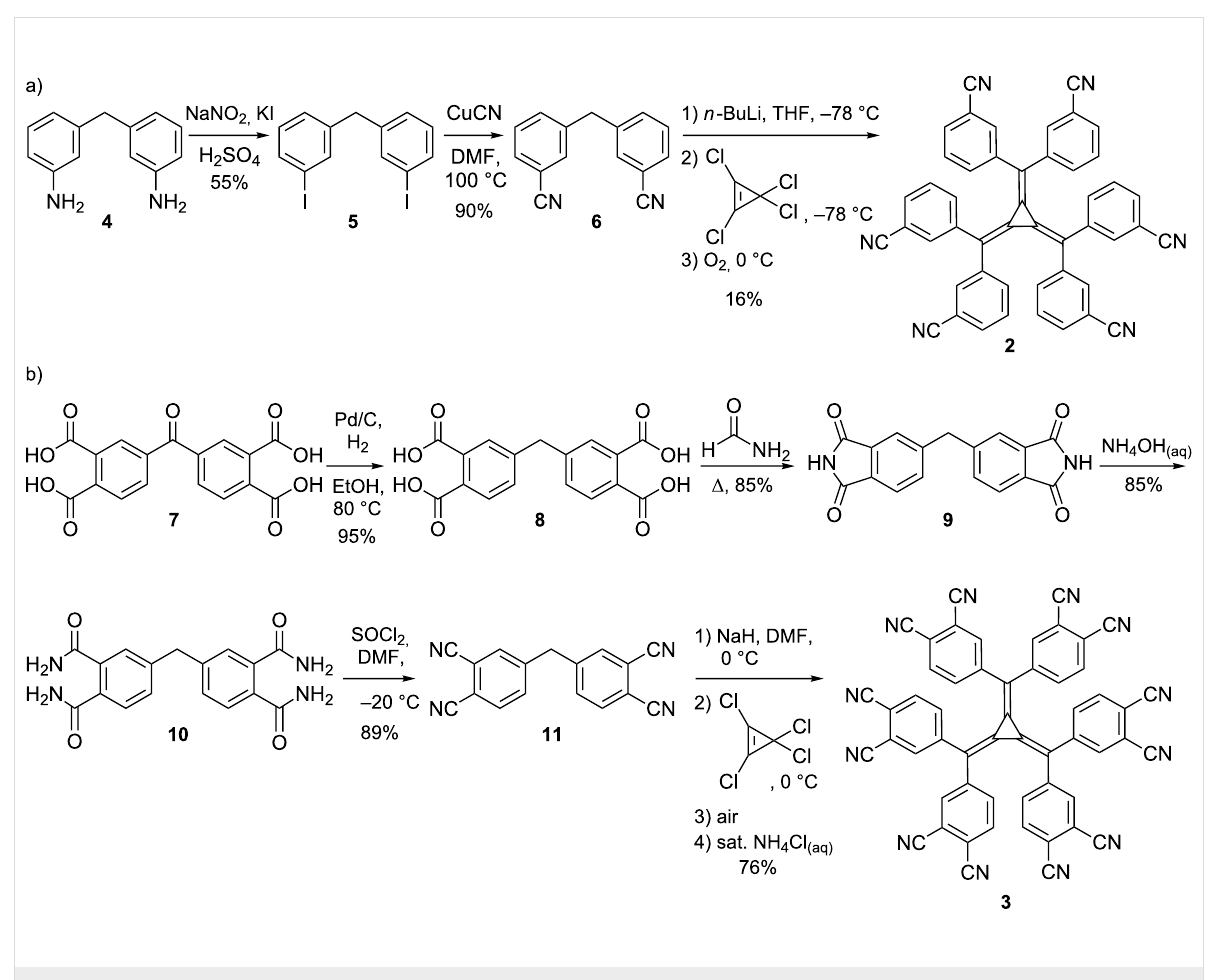
(Figure 2). The small crystals were weakly diffracting but the structure refined to R 1 6.82% with no significant disorder prob- “arms” extend in a double-bladed propeller conformation with torsion angles of ca. 39° on average which is common for hexa- aryl[3]radialenes [18-20]. The nitrile substituents in the 4-pos- ition extend directly out from the structure in approximately the same plane as the core, whereas those in the 3-position are situ- ated above and below the plane. In the conformation observed, four are up and two are directed down. This type of con- formation is less commonly encountered as symmetrical arrangements of multi-armed compounds, those with no net dipole, are more favoured [38]. Bond lengths and angles about the central core are consistent with a [3]radialene